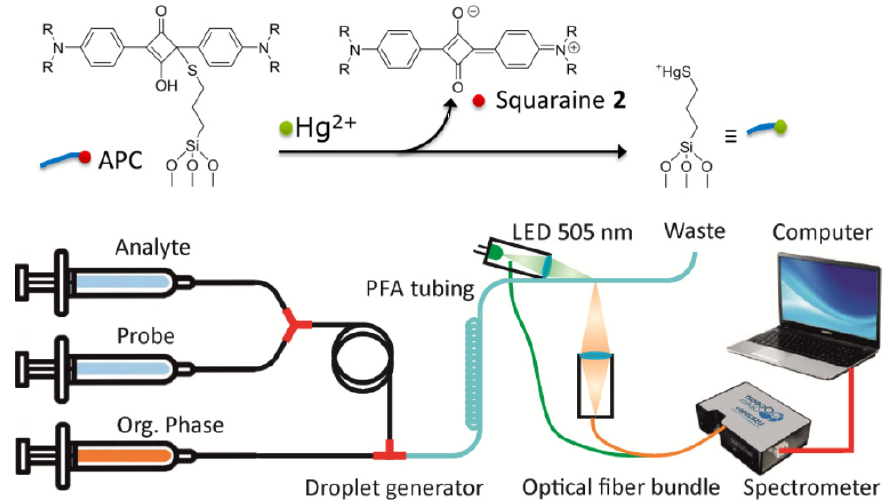
Figure 2. Diagram illustrating the uncapping reaction between 2,4-bis(4-dialkylaminophenyl)-3- hydroxy-4-alkylsulfanylcyclobut-2-enone (APC) and Hg (top) and the microfluidic detection system setup (bottom) [94]. Copyright (2016) American Chemical Society.